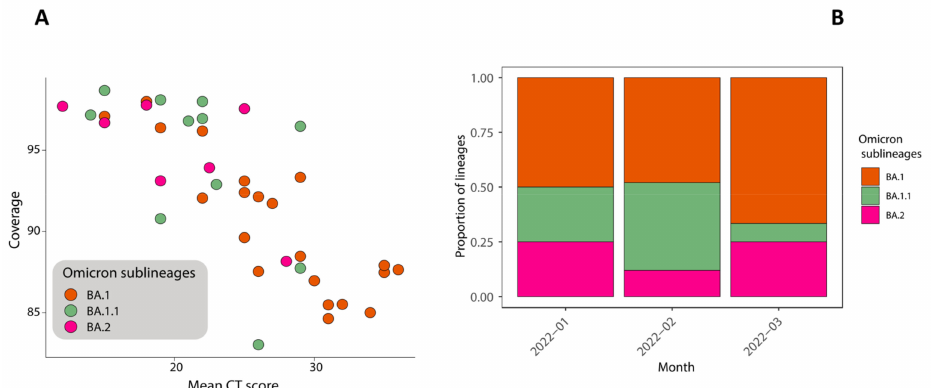
Figure 2. Genome coverage plotted against the mean threshold value of the RT-PCR cycle (CT score); colors represent different omicron sub-lineages (panel A ). Frequency and distribution of the SARS-CoV-2 omicron sub-lineages from the whole-genome sequences generated within the study (panel B